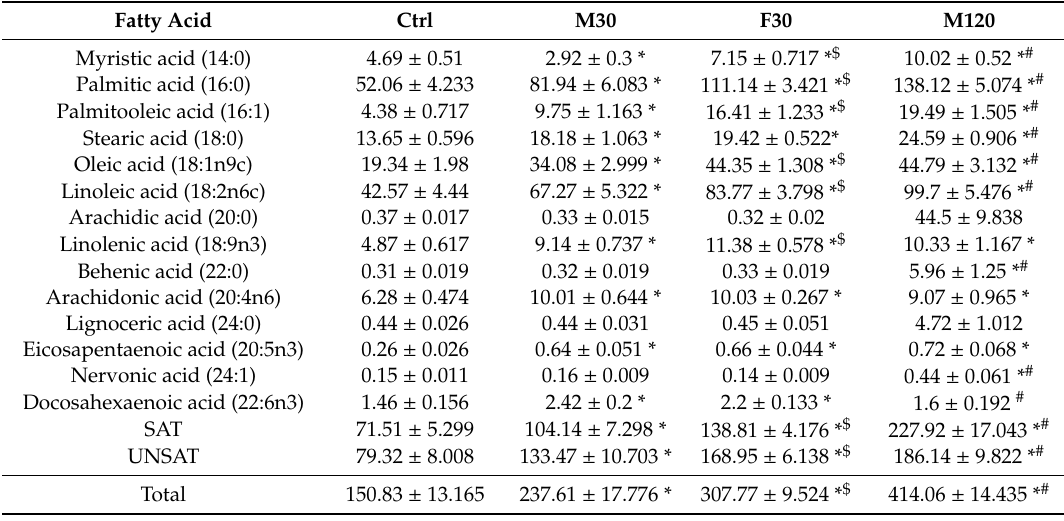
Table 1. Plasma fatty acid composition (FFA) (nmol / mL of